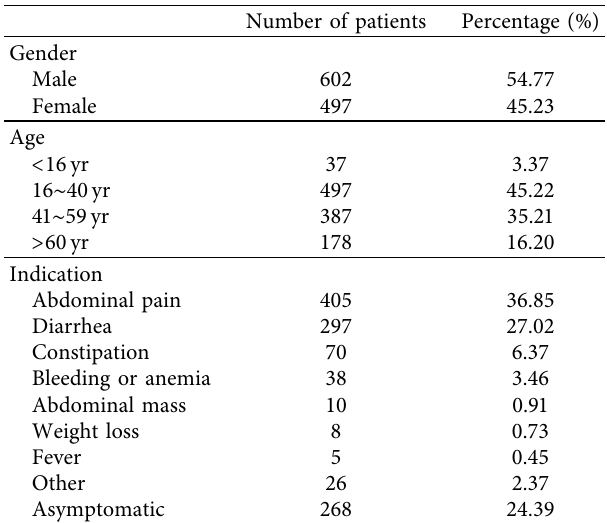
Table 1: Clinical characteristics of patients with terminal ileum